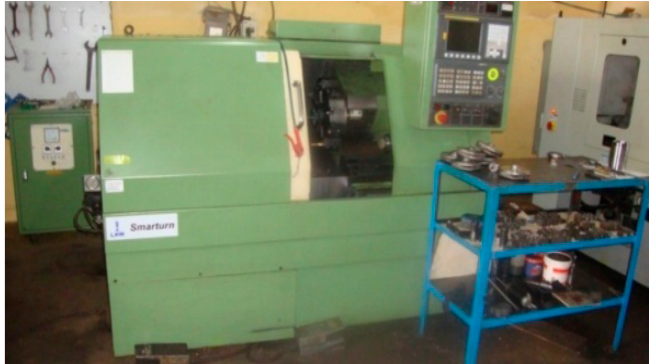
Figure 3. CNC Turning Machine (BATLIBOI smart run CNC lathe).